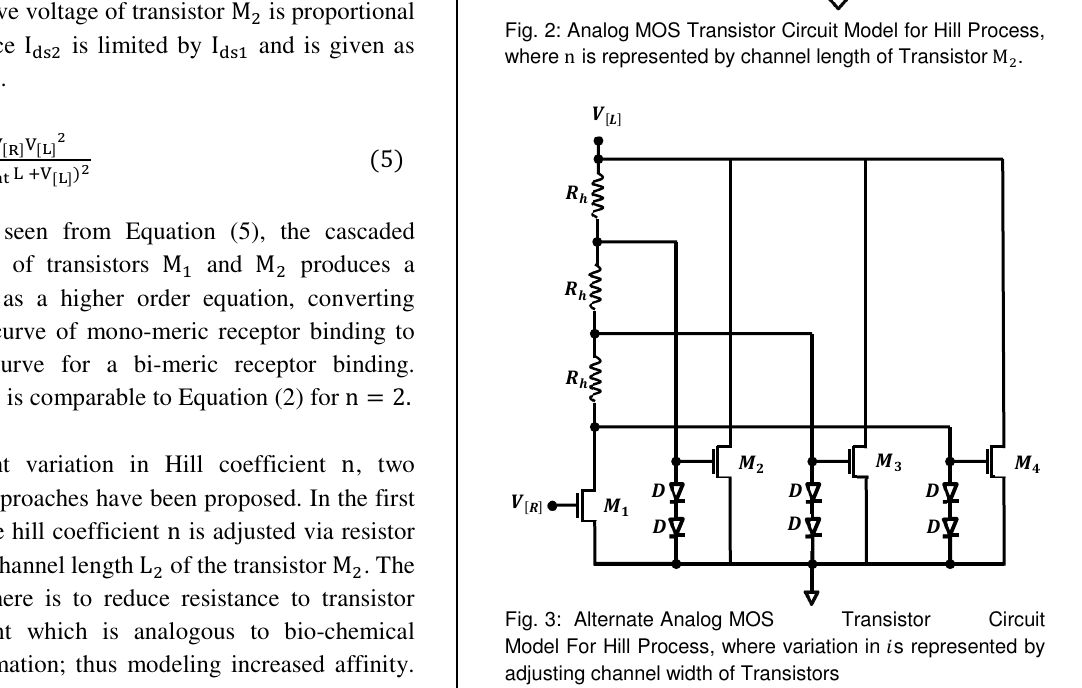
Fig. 3: Alternate Analog MOS Transistor Circuit Model For Hill Process, where variation in 6 s represented by adjusting channel width of